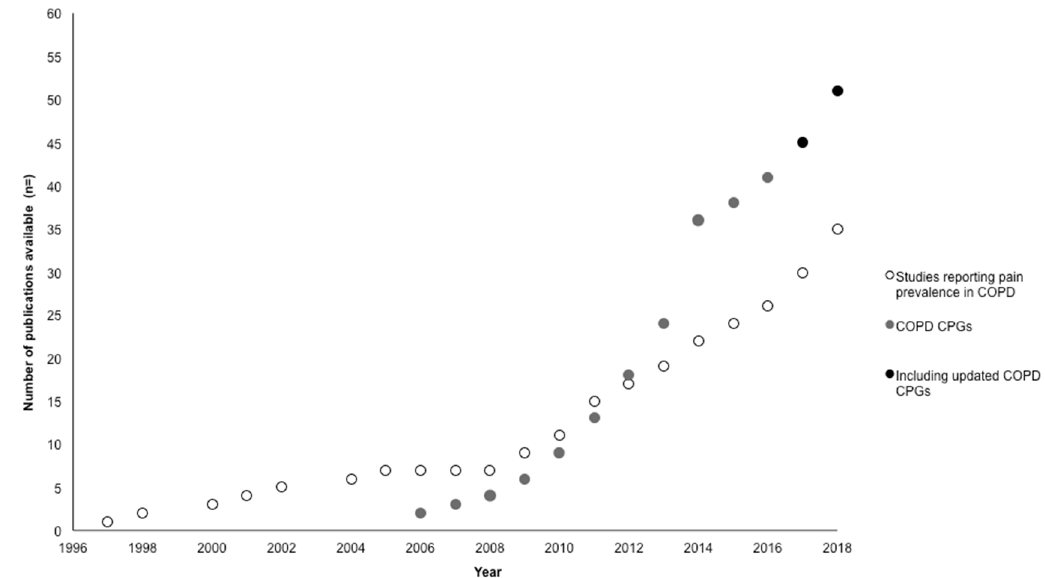
Figure 3. Publication of studies reporting pain prevalence in people with COPD versus COPD clinical practice guidelines (CPGs) included in this review and update.